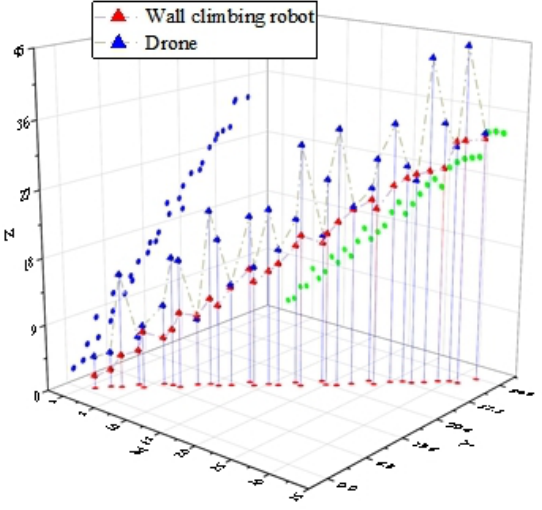
Fig. 5. Complex threat, detection step change diagram